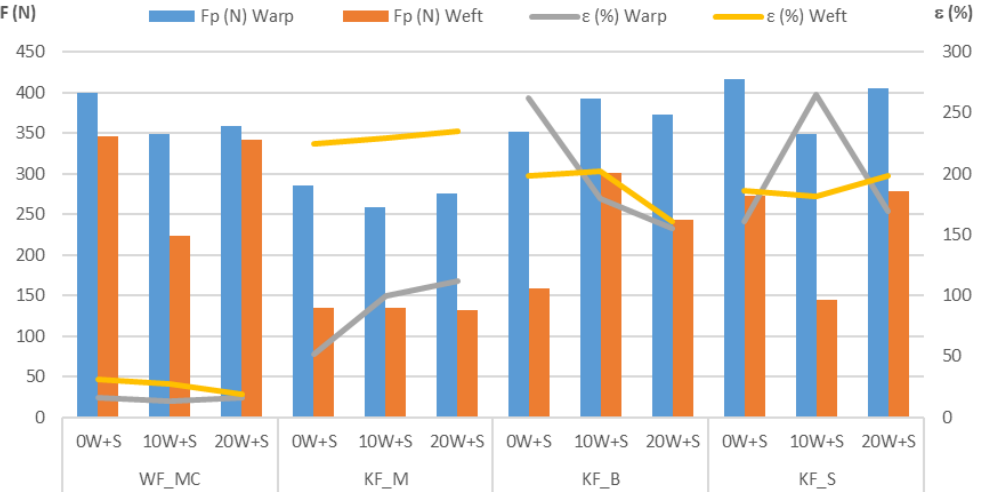
Figure 6. Results of breaking forces (F/N) and breaking elongation ( ɛ /%).